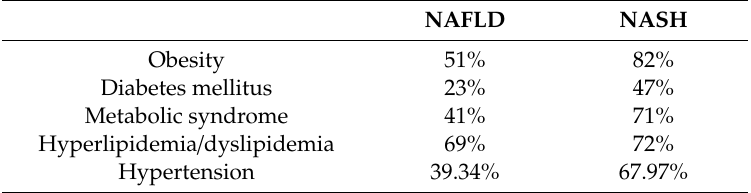
Table 2. Prevalence of metabolic comorbidities in patients with NAFLD and NASH—Data by Younossi